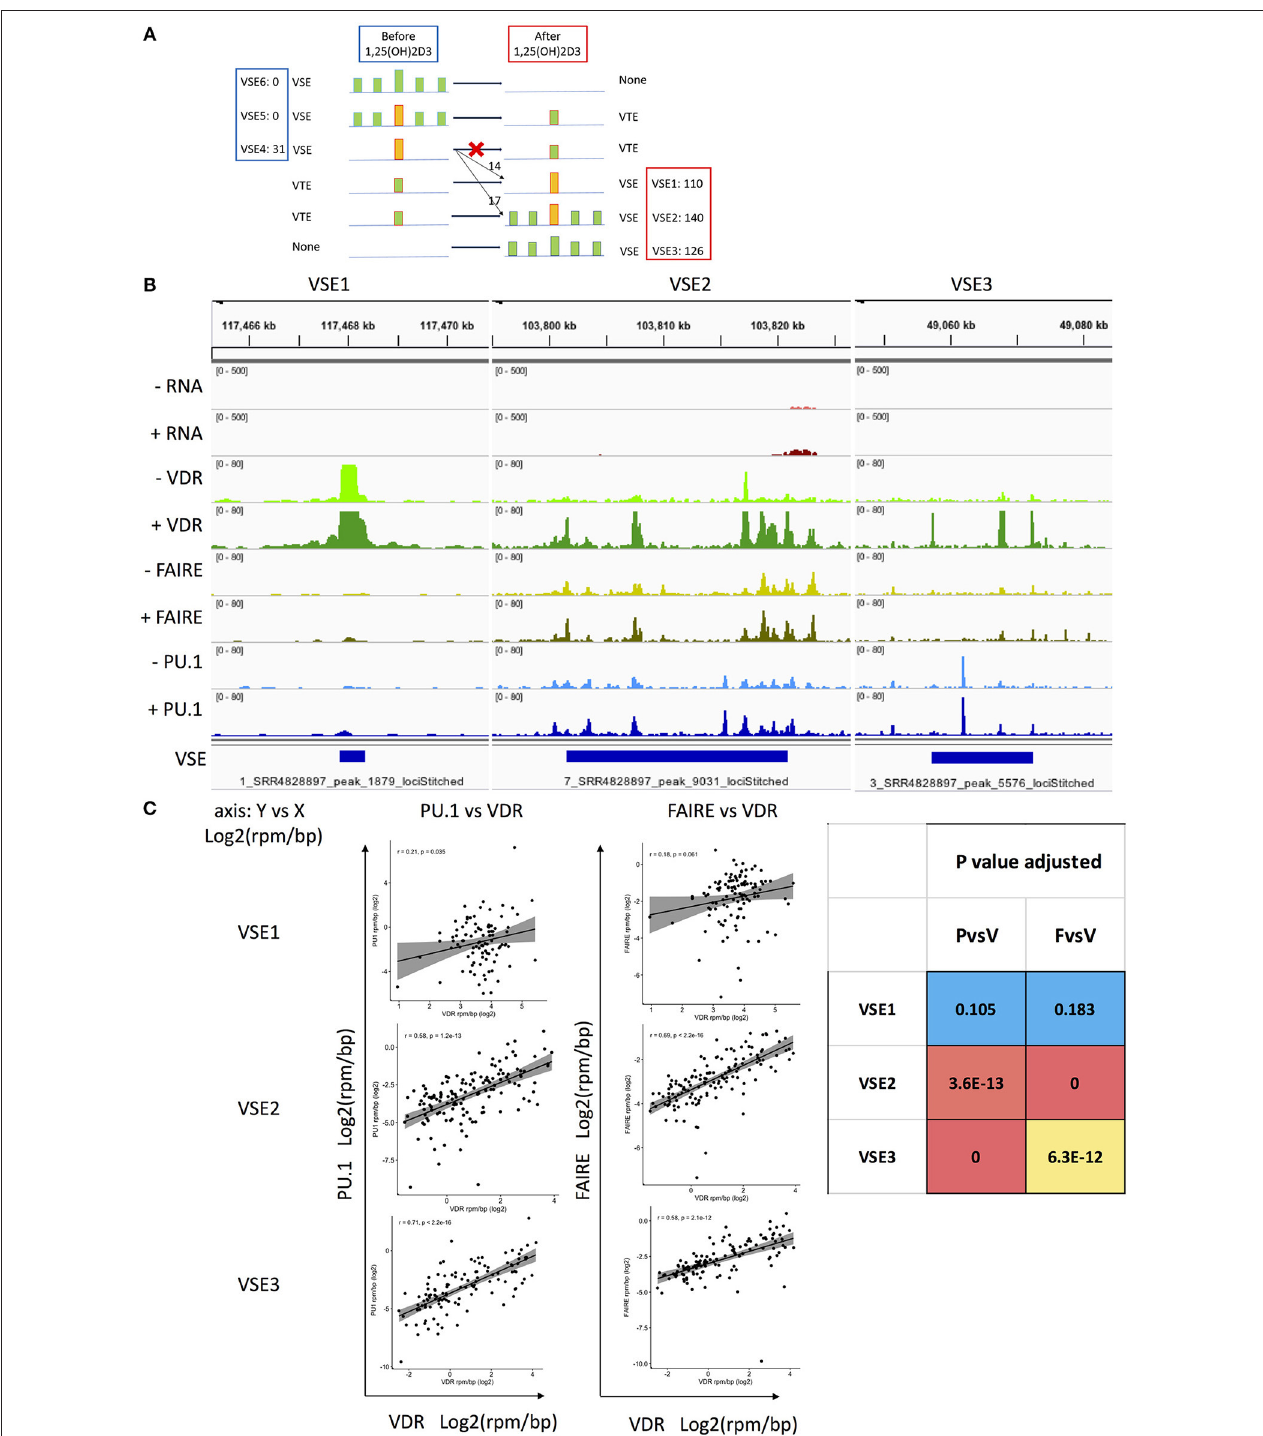
FIGURE 2 | The classification of VSEs and their association with the region and density of PU.1 and FAIRE. (A) Classification hypothesis: six types of VSE pattern. VSE4–6 exist without 1,25(OH) 2 D 3 treatment. VSE1–3 are gained after 1,25(OH) 2 D 3 treatment. VTE, VDR typical enhancer; VSE, VDR SE; PSE, PU.1 SE; FSE, FAIRE SE; yellow bar, high read density in narrow region identified as SE; read density of bar, yellow > green; blue line, genomic region; The colon of VSE1–6 followed by the number of locations observed that match the pattern in THP-1 cells. (B) The representative genomic binding density of VDR, FAIRE, and PU.1 in VSE1–3. (C) The signal density correlation between PU.1, VDR and FAIRE in VSE1–3 regions.